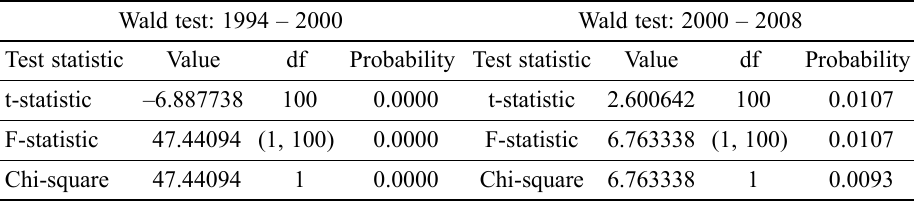
Table 3. Tests of constant returns to scale of the EU-7 countries Wald test: 1994 – 2000 Wald test: 2000 –